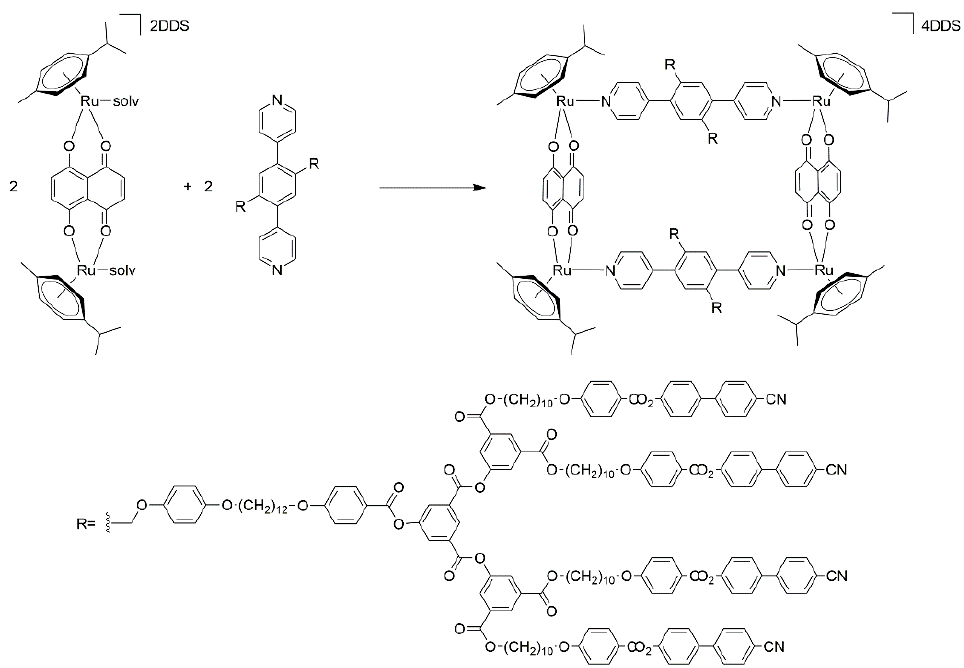
Scheme 2. Synthesis of an arene-ruthenium metalla-cycle from a functionalized dendritic bis-pyridyl linker [37].